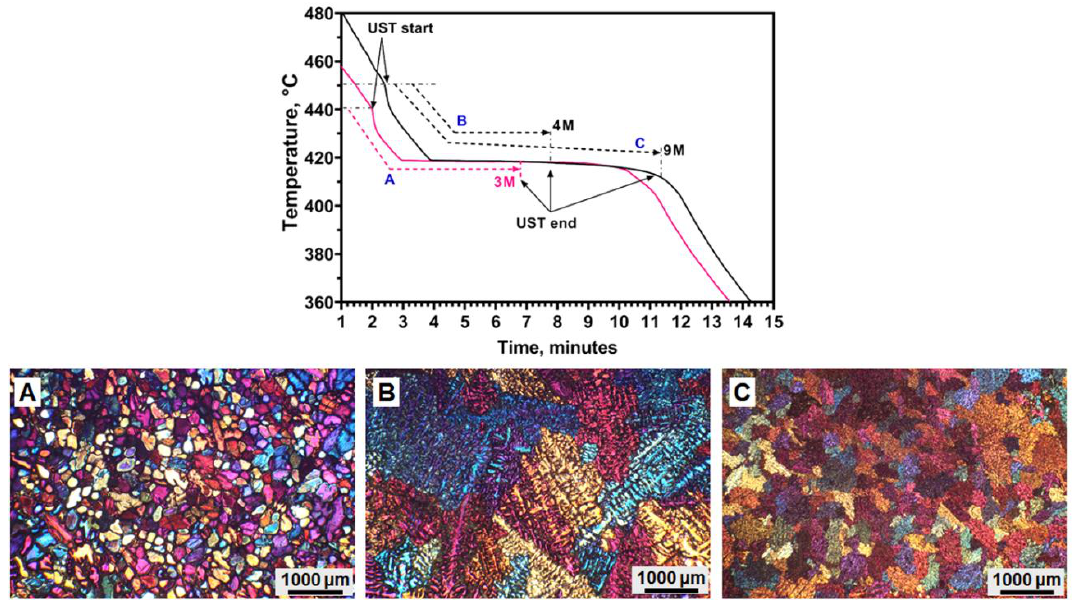
Figure 14. Cooling curve of pure Zn showing three different temperature ranges of UST application A , B , C and their corresponding microstructures taken from the centre of the casting.